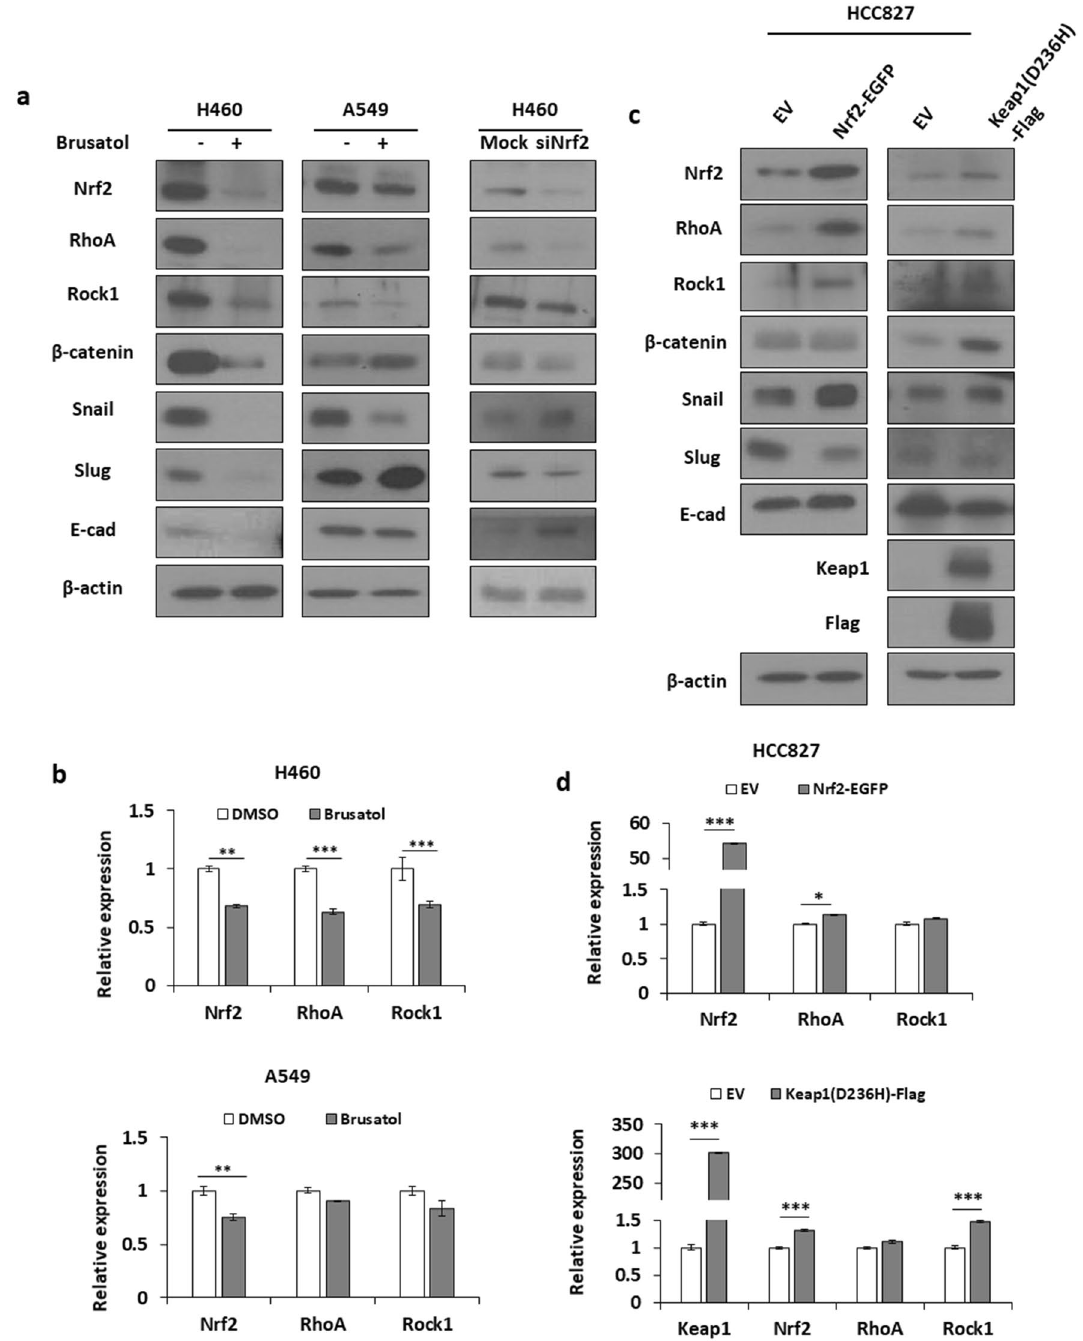
Figure 3. Molecules from the RhoA-ROCK1 pathway, and not the EMT-related molecules, are associated with Nrf2-induced cell motility. The expression levels of Nrf2, RhoA, Rock1, and/or EMT markers were detected using ( a , c ) western blotting or ( b , d ) qRT-PCR. ( a , b ) Nrf2 was suppressed by treating the A549 or H460 cells with brusatol (10 nM) or transfection of Keap1-Flag or siNrf2. ( c , d ) Nrf2 was overexpressed by